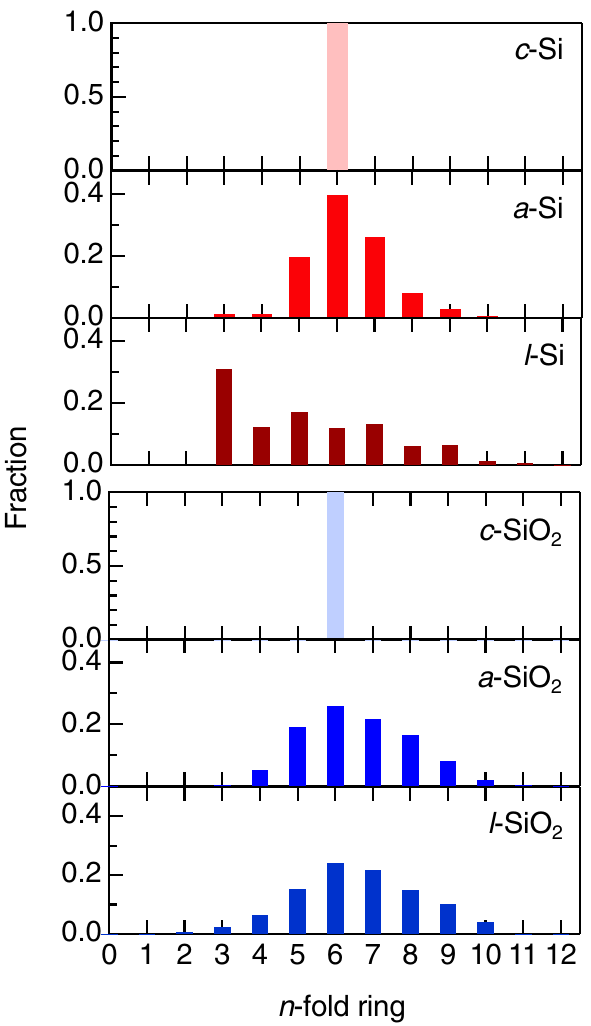
Figure 4. Primitive ring size distributions in a series of Si and SiO 2 . The results of a -Si, l -Si (1770 K), and l -SiO 2 (2373 K) are calculated using a structural model obtained by combined molecular dynamics (MD)–reverse Monte Carlo (RMC) modeling 29 , RMC modeling 29 , and MD simulation 31 , respectively. The results of a -SiO 2 are taken from ref. 29. It is confirmed that the ring size distribution of l -Si obtained by RMC modeling is identical to the result obtained by density functional (DF)–MD simulation shown in Fig. S3. Since the Si–O-Si bond angle is nearly straight 2 in SiO 2 , we define that a sixfold ring consists of six SiO 4 tetrahera, which allows us to decorate oxygen atoms in the analysis. Note that it is not appropriate to compare the ring statistics of l- Si with those of a -Si and SiO 2 , since the structure of l -Si is beyond the scope of the corner-sharing tetrahedra motif owing to a significantly increased Si–Si coordination